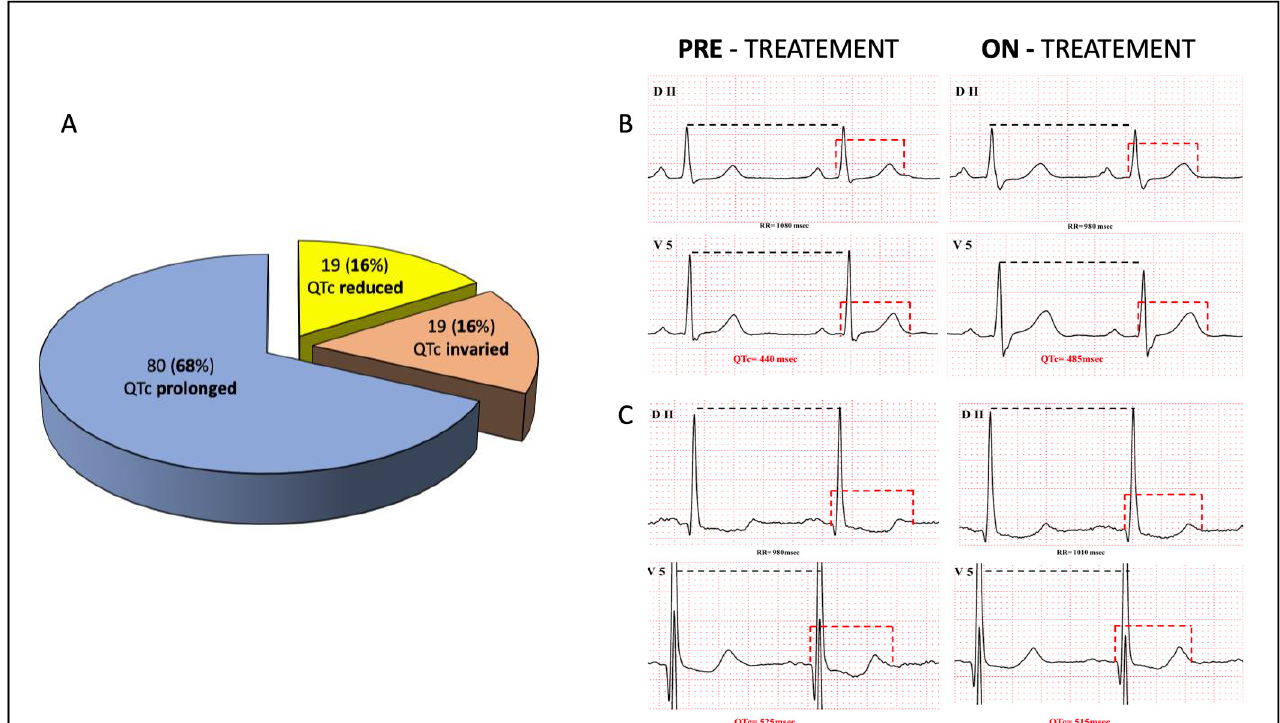
Figure 2. Spectrum of QTc interval changes during disopyramide treatment. In panel ( A ), the spectrum of QT variation following disopyramide therapy is reported. Panel ( B ) shows a case of QT prolongation during treatment, whereas Panel ( C ) represents a patient with QT shortening while on disopyramide. Table 4. Collateral effects of patients undergoing disopyramide